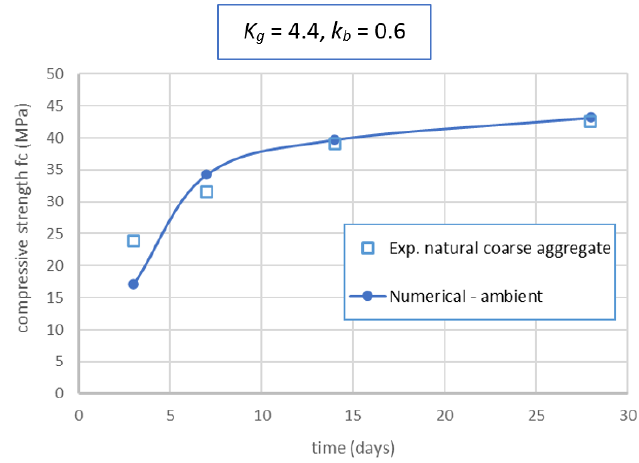
Figure 21. Comparison of experimental and numerical results obtained by modified Feret’s model for geopolymer concrete with natural coarse aggregate.